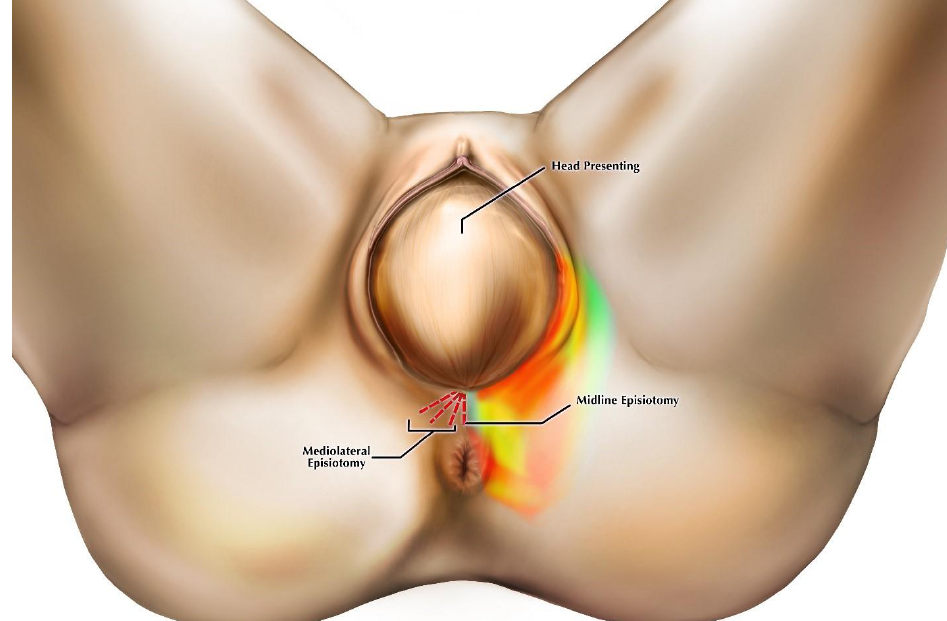
Figure 5. Heat map of risk of perineal structure injury at the time of crowning based on anatomic variation in our sample. Red-orange indicates high risk and green-blue low risk. Red dashed lines show the locations of episiotomy incisions.